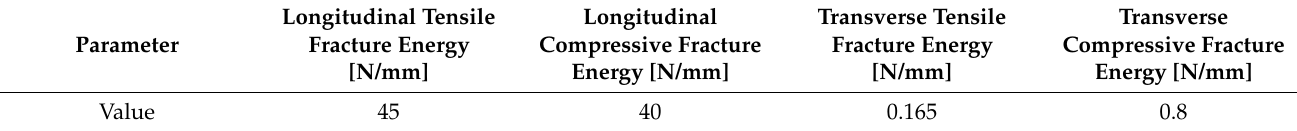
Table 8. Parameters defined in the material damage evolution